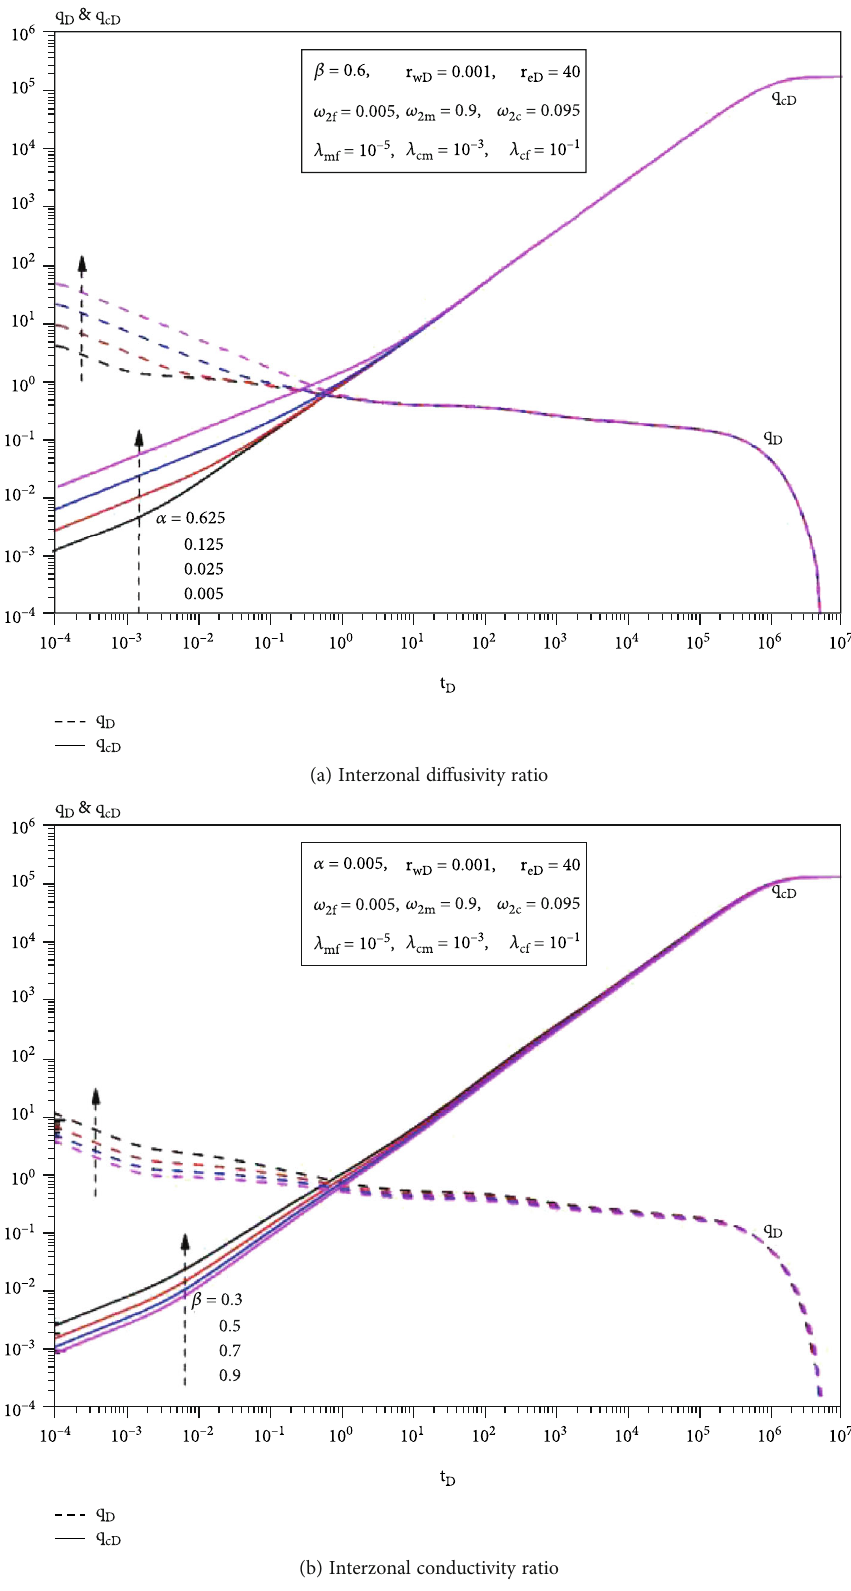
Figure 7: In fl uence of interzonal di ff usivity ratio and interzonal conductivity ratio on the production of an AFVW in a pore-cavity-fracture carbonate